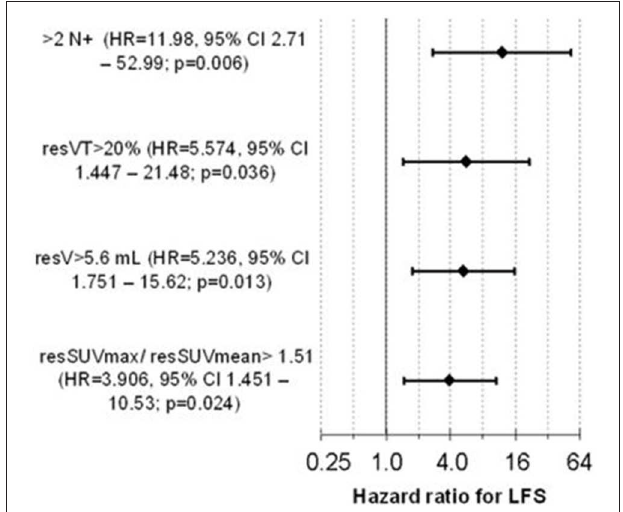
FIGURE 2 | The Cox proportional hazard model for laryngectomy-free survival (LFS) developed in responders (p = 6.28 × 10–4) contains 4 independent significant covariates and predicts the LFS, overall (OS), and tumor- specific survival (TSS) of responders Forrest plot for the four covariates in the multivariate Cox model (1) suspect positive neck nodes (N + ) ≤ 2 vs. > 2, (2) residual volume of the primary tumor resVT ≤ 20 vs. > 20%, (3) residual total tumor volume in CT-based volumetry resV ≤ 5.6 vs. > 5.6ml, and (4) the ratio of the residual standard-uptake value maximum and the residual standard-uptake value mean resSUVmax/resSUVmean ≤ 1.51 vs. > 1.51. Fifty two consecutive patients with advanced laryngeal and hypopharyngeal carcinoma in the